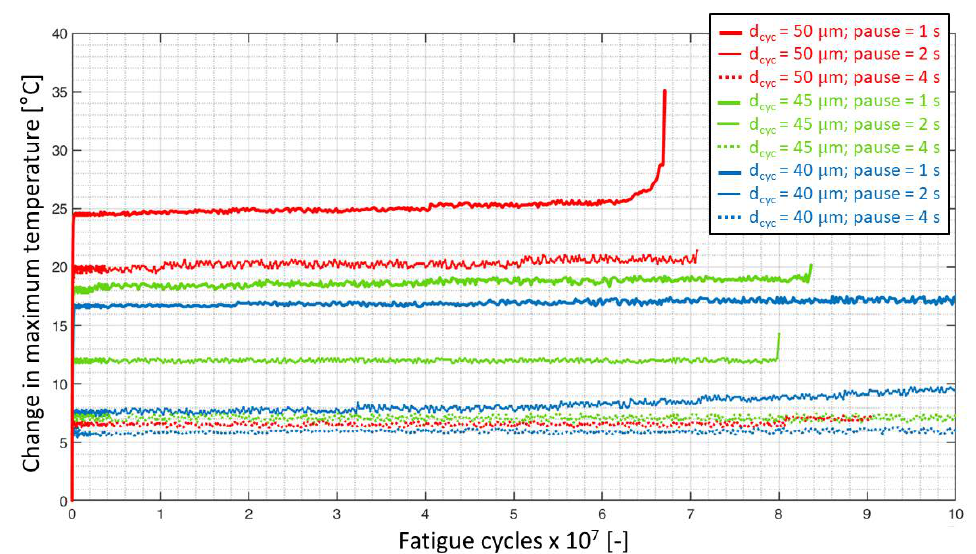
Figure 9. The change in maximum surface temperature near the contact regions against the fatigue life of the VHCF specimens tested at 20 kHz in three different load amplitudes and pause